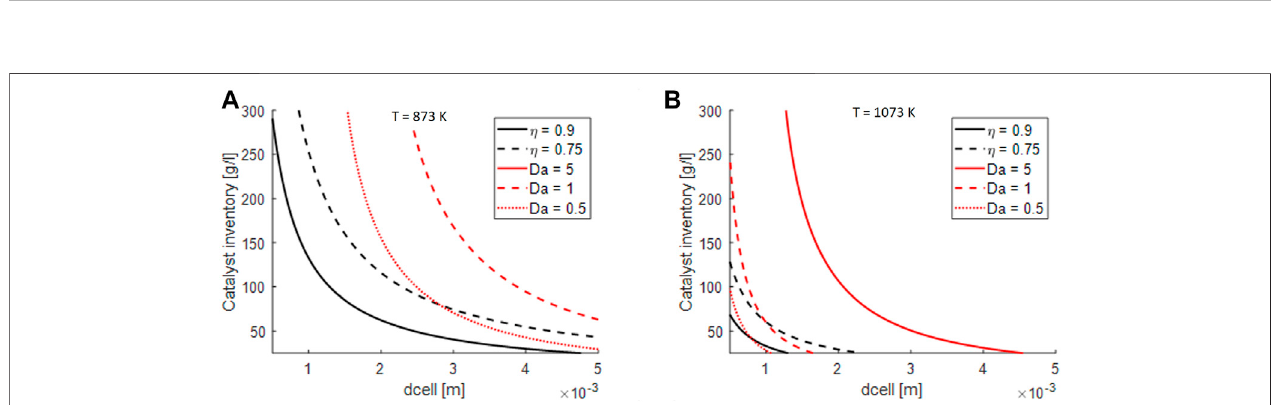
FIGURE9| Impactofexternalandinternalmasstransferlimitationsondesignparametersofopen-cellfoamsatGHSV (cid:2) 40.000h − 1 : (A) considerationsforS/C (cid:2) 4 and T (cid:2) 873 K, p (cid:2) 1 atm, (B) considerations for S/C (cid:2) 4 and T (cid:2) 1073 K, p (cid:2) 1 atm.